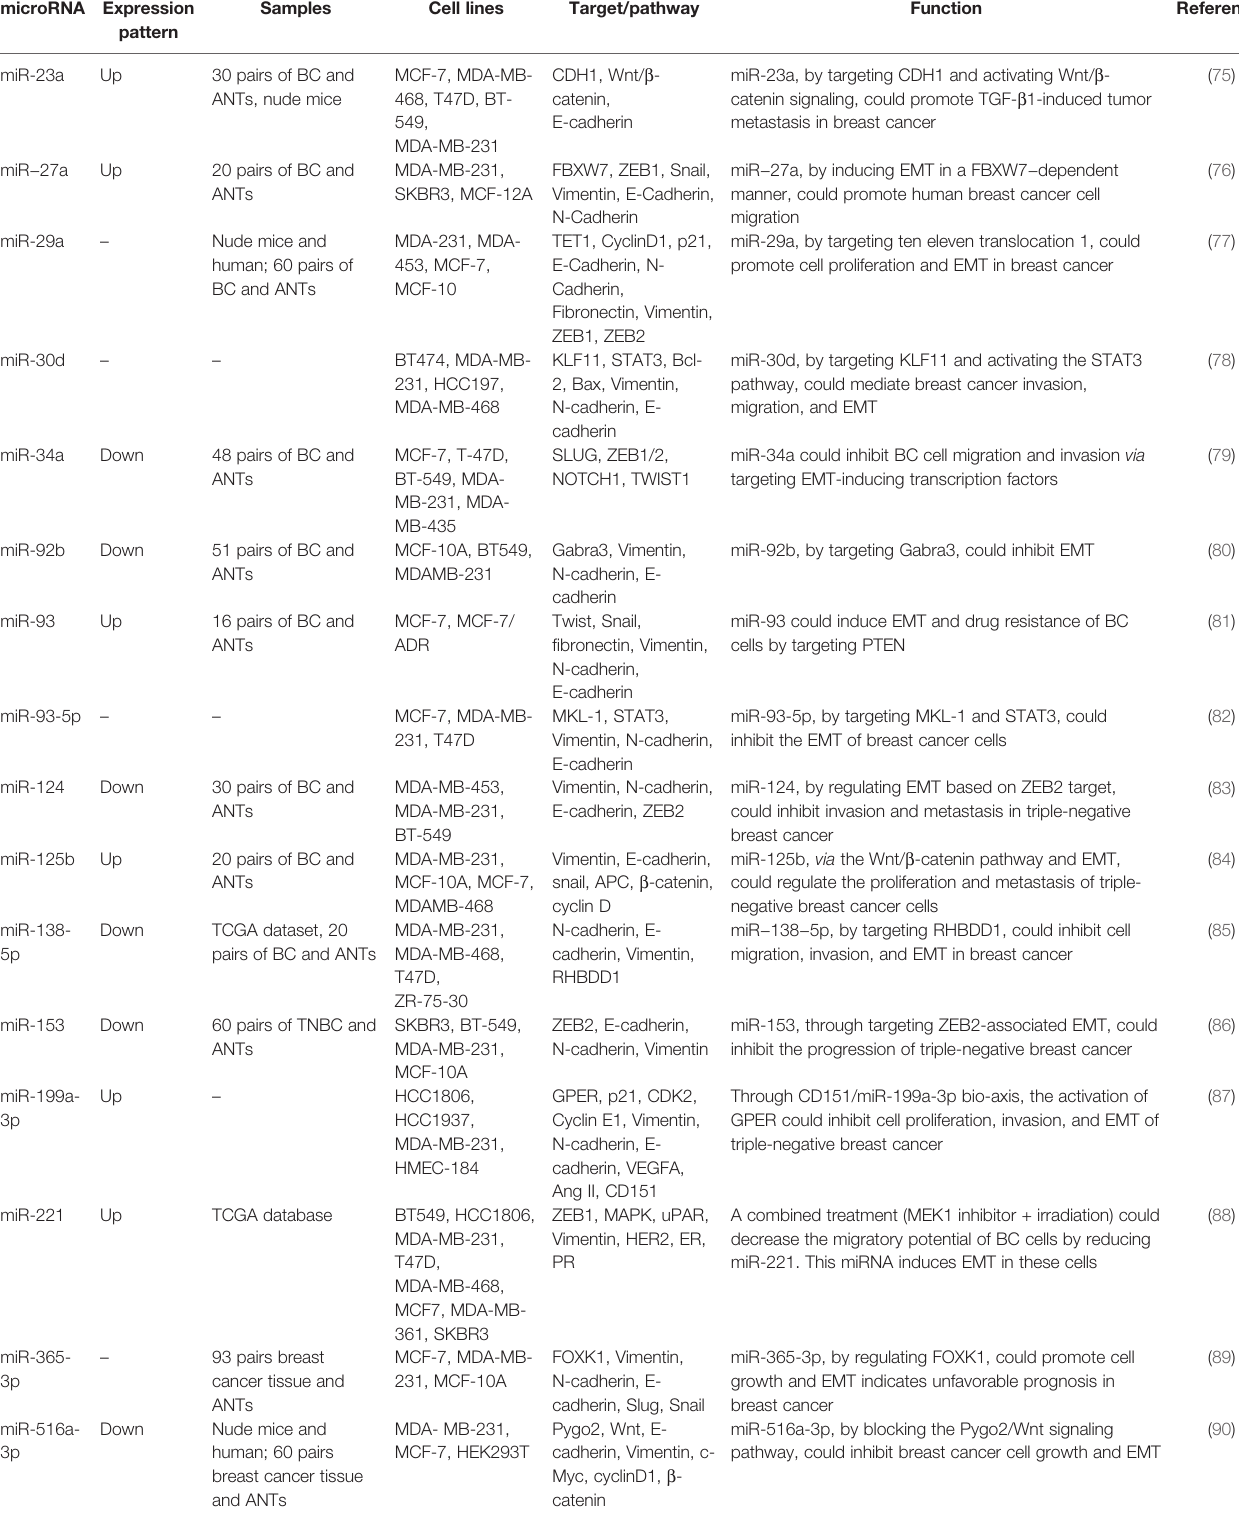
TABLE 3 | Regulation of epithelial – mesenchymal transition (EMT) by miRNAs in breast cancer. microRNA Expression